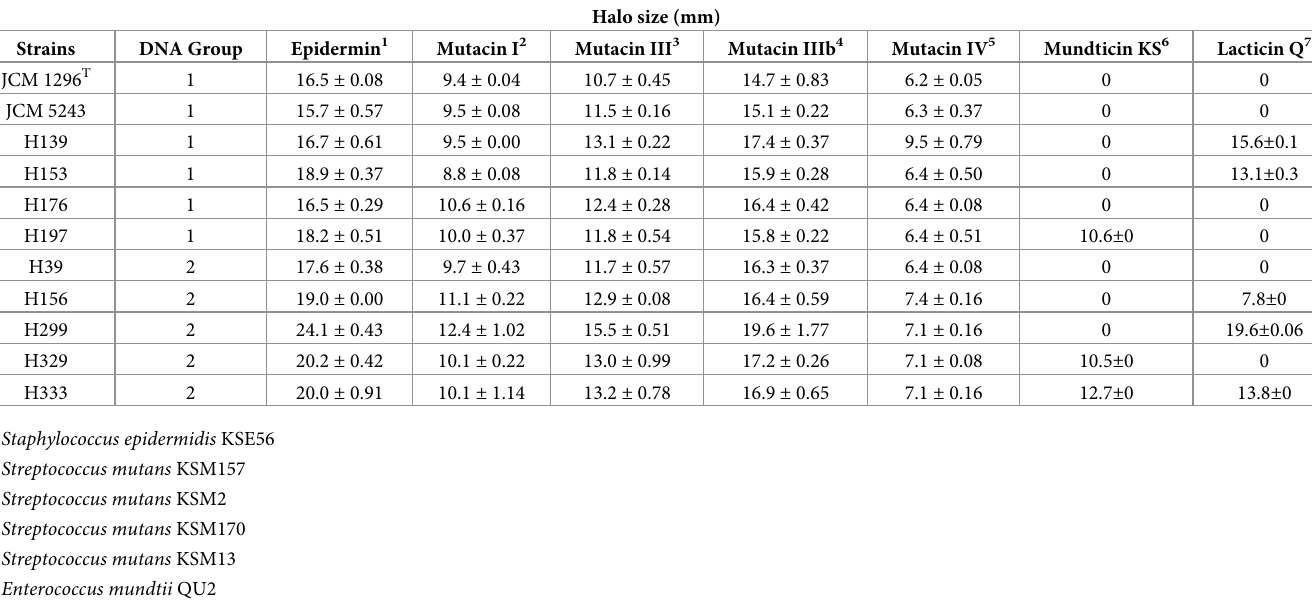
Table 3. Susceptibility to various bacteriocin-producing strains by direct